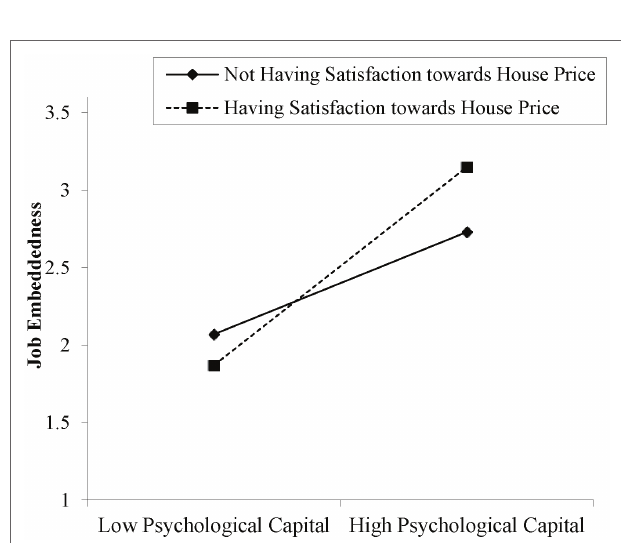
FIGURE 3 | Moderation role of housing contribution to housing funds between psychological capital and job embeddedness.